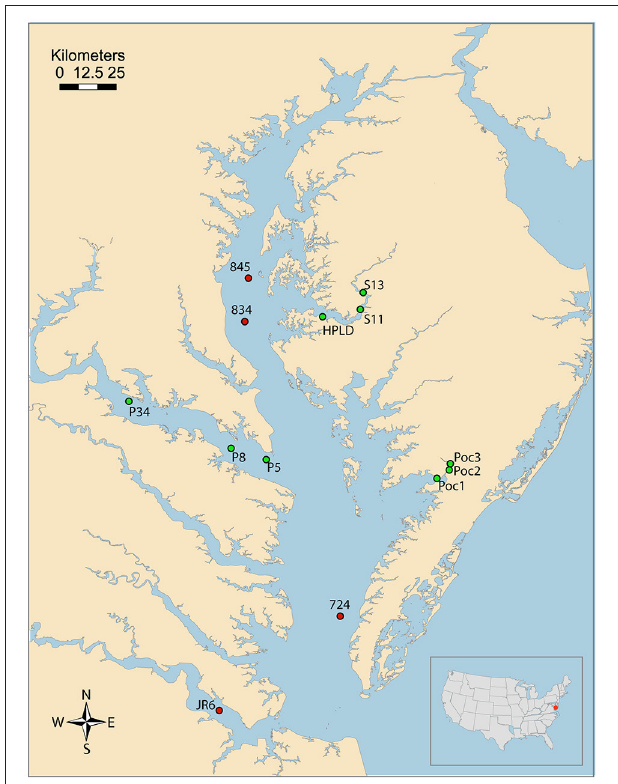
FIGURE 1 | Map of Chesapeake Bay Ecosystem with approximate location of all sampling stations. Stations where dilution experiments were performed are marked with a red circle and experiments where fluorescently labeled cryptophytes were used are marked with a green circle. Map edited from original source: Saxby, T. and Boicourt, K., Integration and Application Network, University of Maryland Center for Environmental Science